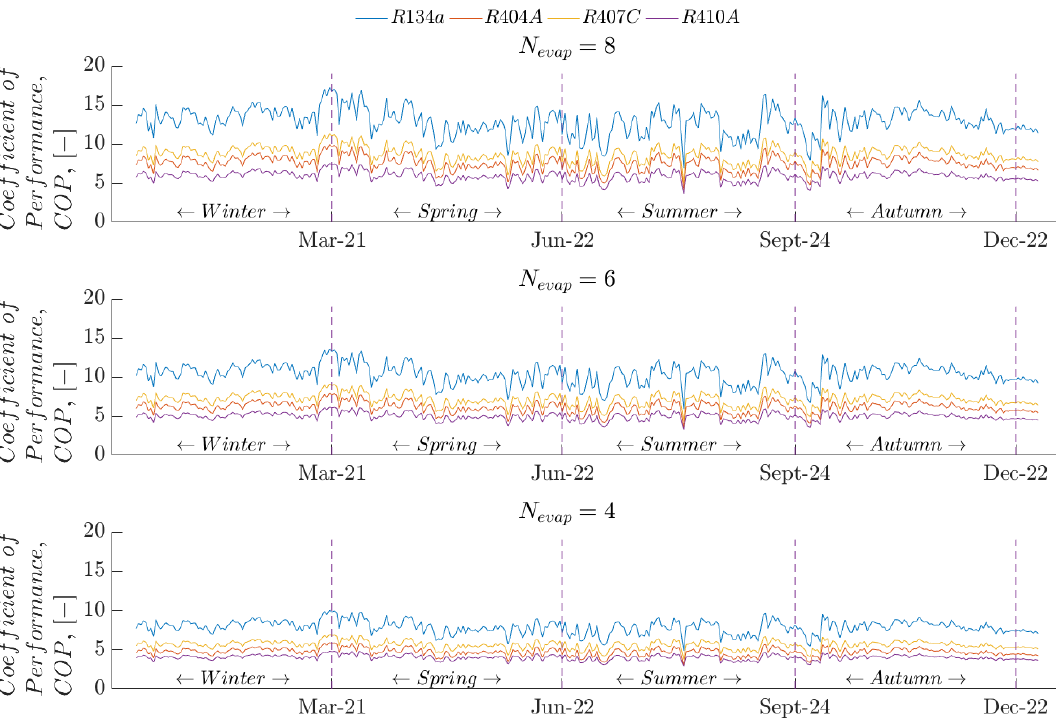
Figure 14. Coefficient of performance throughout the year for all refrigerants and for 4, 6 and 8 flat-plate solar collectors.